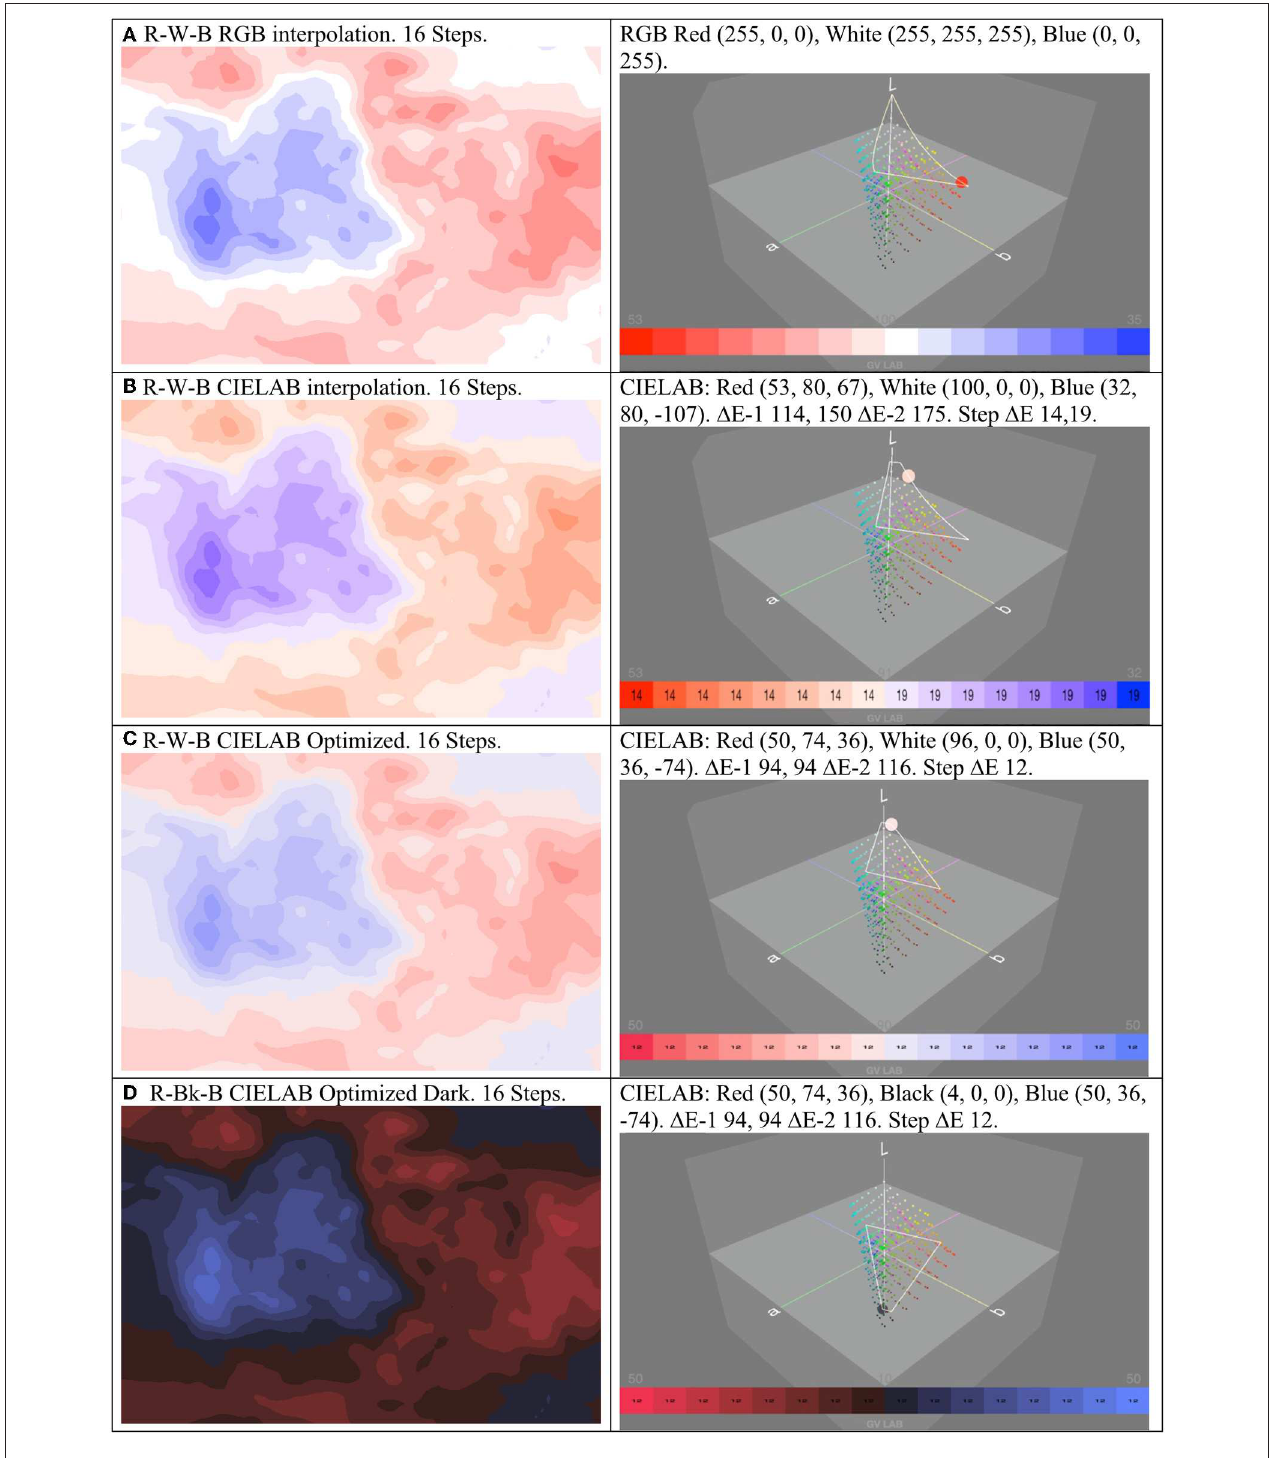
FIGURE 6 | Further comparative visualizations generated using the Gradient Designer and LAB Color Mixer Apps (left column) shown with supporting insights in CIELAB color space provided through the GV_LAB App (right column). (A) R-W-B non-linear RGB interpolation 16 Steps; (B) R-W-B CIELAB interpolation 16 Steps. Red and Blue Values match 6 (A) , Blue-White interpolation is sRGB gamut constrained; (C) R-W-B linear CIELAB Optimized 16 Steps, Red and Blue are Isoluminant (L = 50), all colors within sRGB gamut; (D) R-Bk-B CIELAB Optimized Dark 16 Steps. Red/Blue as per 6 (C) , Black L = 4. CIELAB colorspace conversions use D 65 2 ◦ illuminant. High resolution: https://doi.org/10.5281/zenodo.3264037.